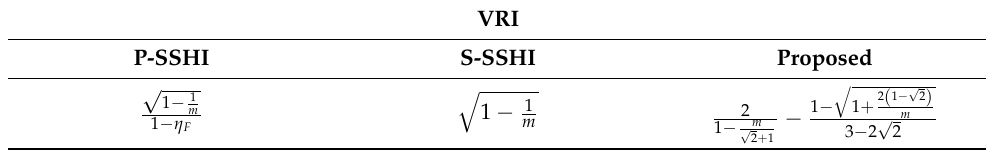
Table 2. Comparison of the VRI of the three different circuits.